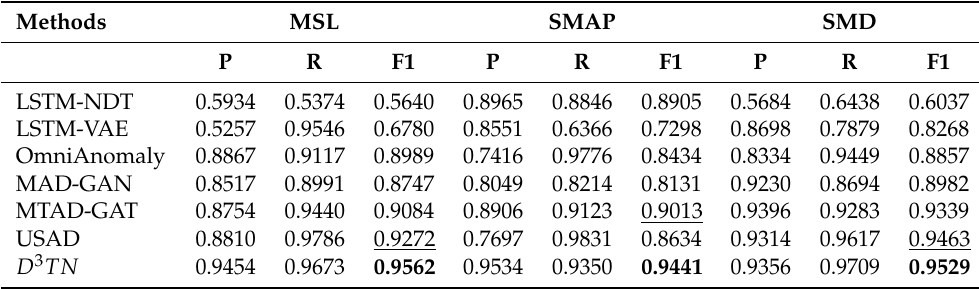
Table 2. Performance comparison of the 3 datasets using precision (P), recall (R), and F1-score (F1). The top results are highlighted in bold and the secondary results are underlined.